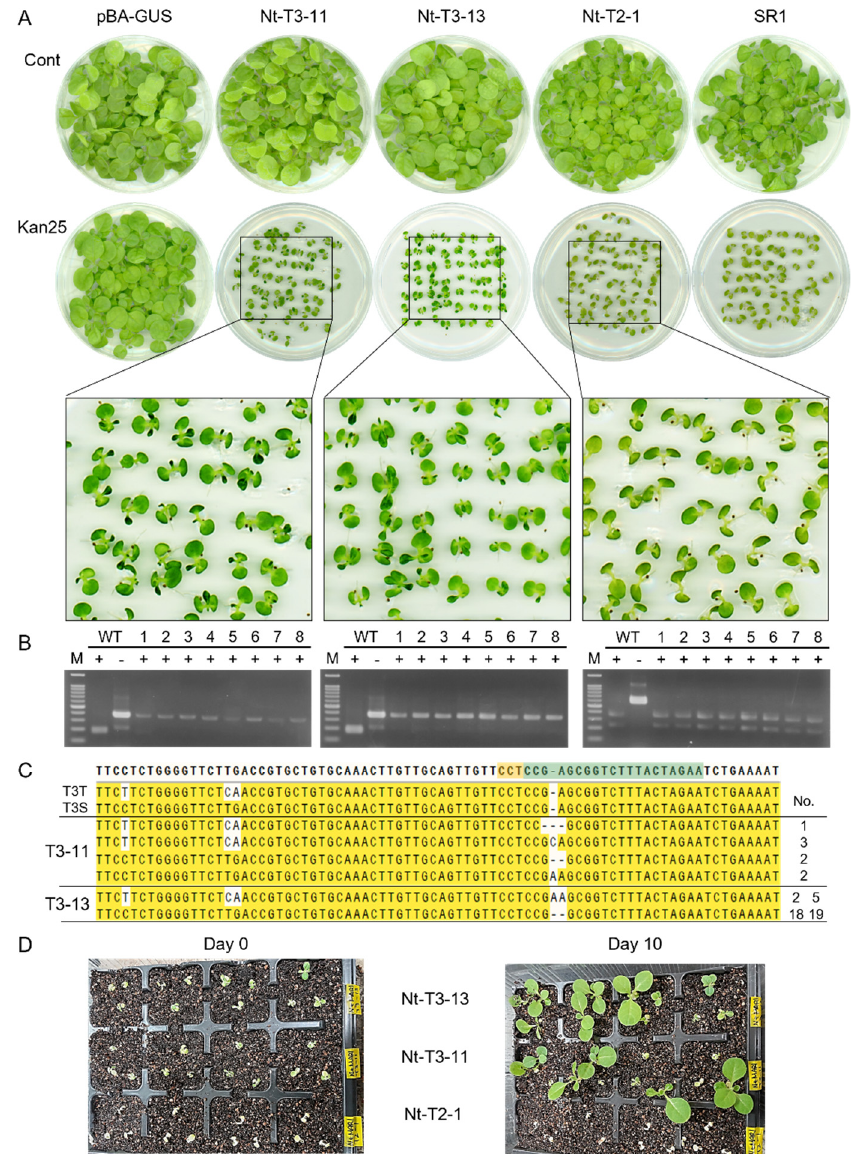
Figure 5. ( A ) limited aminoglycoside resistance of NtMAR1S / NtMAR1T -knockout N. tabacum . ( A ) growth of wild-type (SR1) and T 1 seedlings of transgenic tobacco lines with a kanamycin resistance gene (pBA-GUS), and candidates of NtMAR1S / NtMAR1T -knockout plants (T2-1, T3-11, and T3-13) on the media with (Kan25) or without (Cont) 25 mg/L kanamycin. Enlarged images of seedlings from three candidate lines are shown. ( B ) The CAPS analyses of NtMAR1S / NtMAR1T in three candidate lines. M, Molecular marker; WT, Wild type; 1–8, T 1 individuals; +, restriction enzyme digested PCR products; -, undigested PCR products. ( C ) Sanger sequencing results of PCR products from a single Nt-T3-11 seedling and two Nt-T3-13 seedlings. The S-genome sequence is shown on the top, with the target sequence in green and the PAM site in yellow highlights. T3T, T-genome sequence encompassing the T3 target sequence; T3S, S-genome sequence encompassing the T3 target sequence; No., the clone numbers for the indicated sequences. ( D ) Growth of seedlings of three candidate lines after 10 days in soil. Seedlings grown for 5 weeks in the presence of 25 mg/L kanamycin were transferred to soil and grown for 10 days. As a control, Nt-T2-1 is